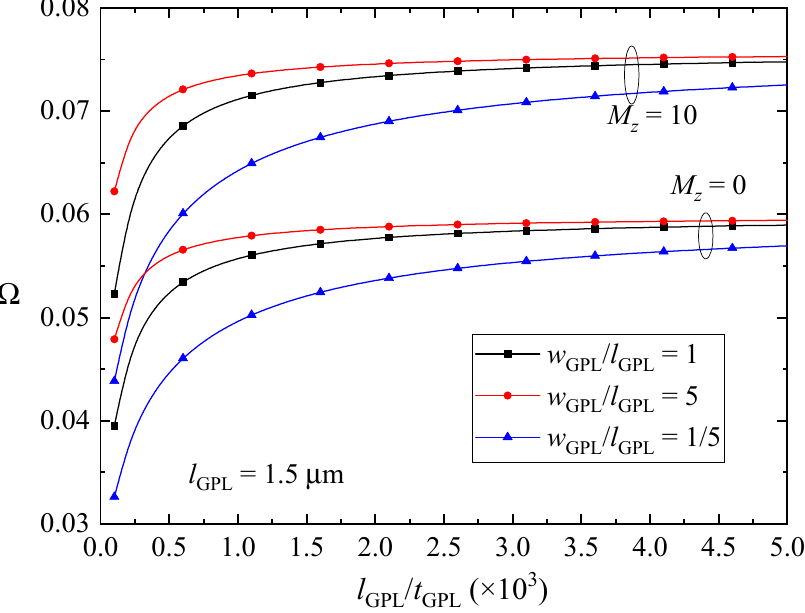
Ω of the beams in the